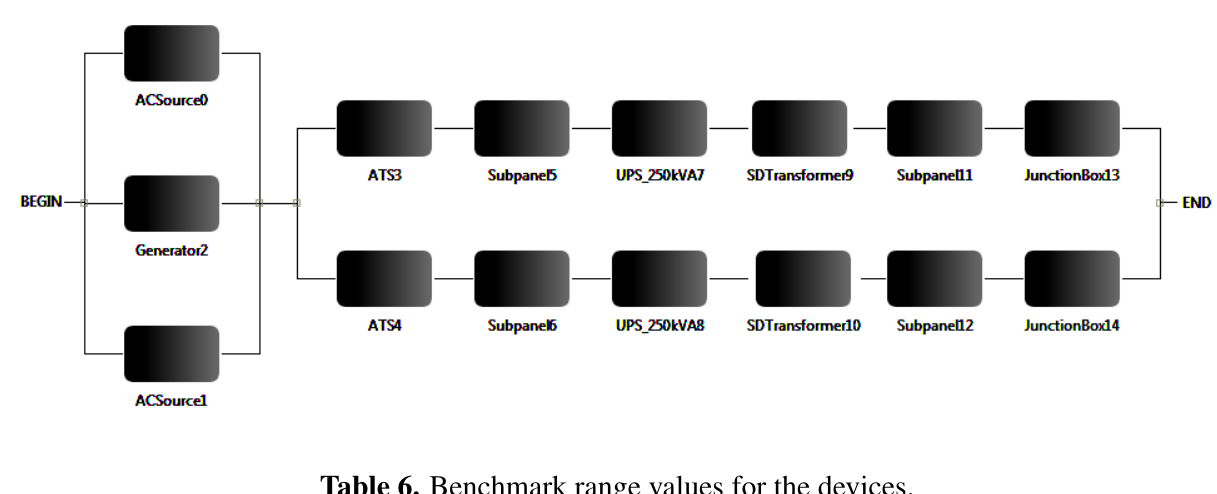
Table 6. Benchmark range values for the devices.